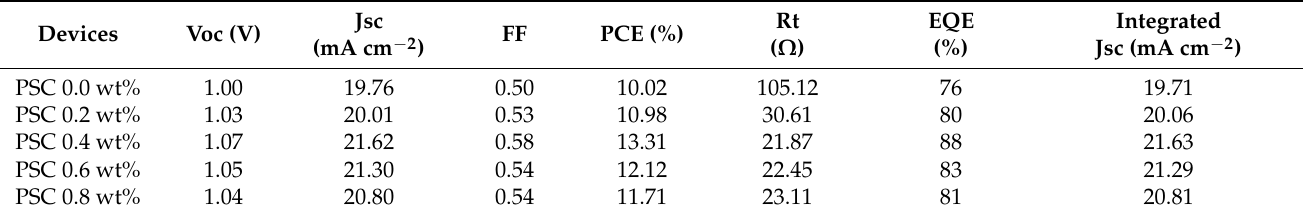
Table 2. Photovoltaic data of PSCs based on Spiro-OMeTAD doped different CsI concentrations.